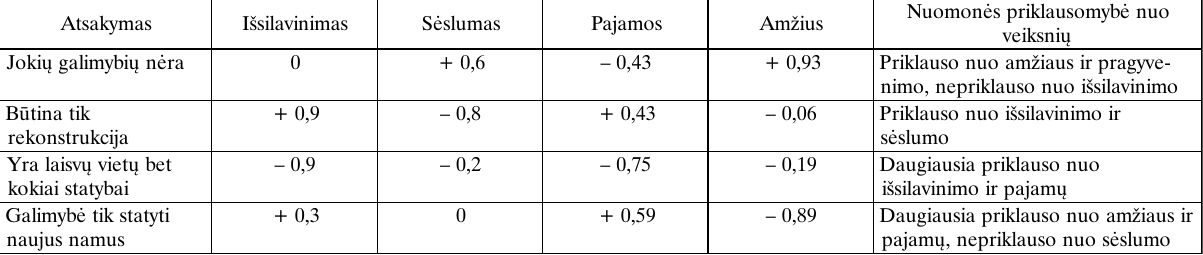
Table 1. Citizens’ assessment of new and additional construction depending on age, education, incomes, settled way of life samykastA saminivalisšI samulsėS somajaP suižmA 0 6,0+